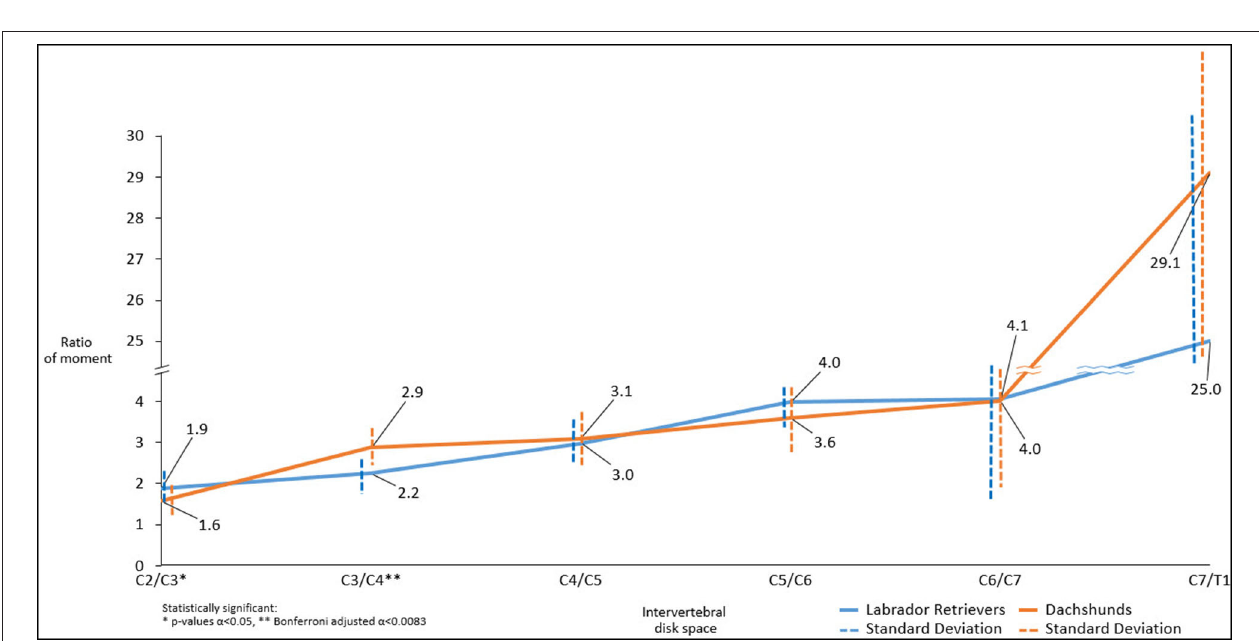
FIGURE 7 | Line graph showing mean ratio of moments determined along cervical spine of Dachshunds (orange) and Labrador Retrievers (blue) measured in transverse computed tomographic images. For accurate presentation, measurements pictured are rounded to one decimal place.